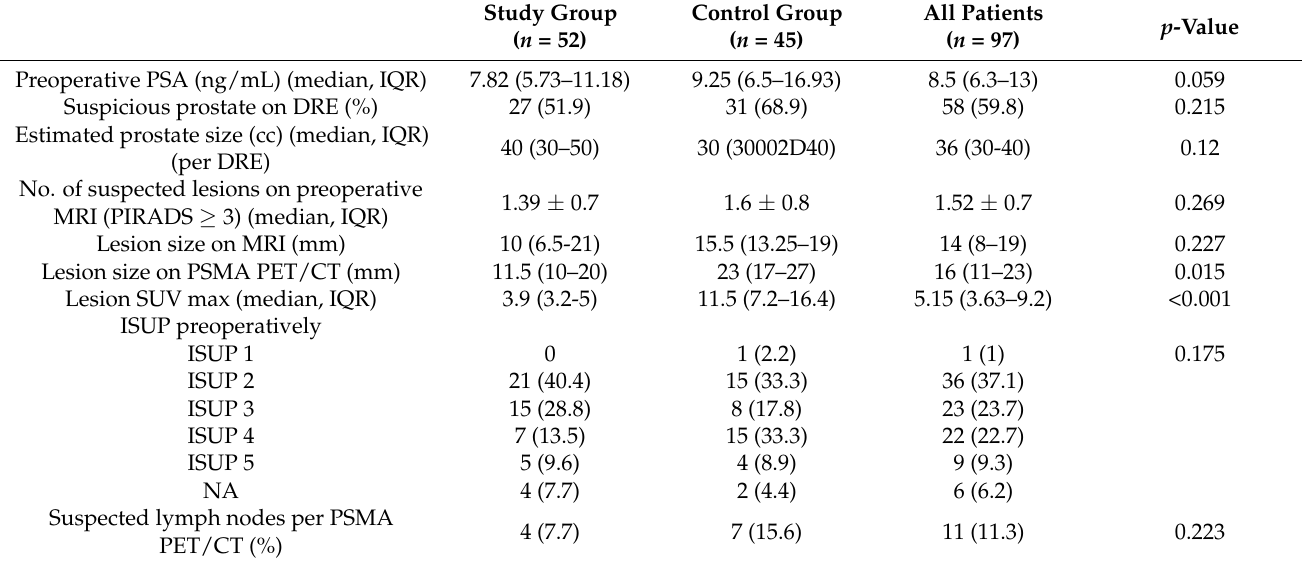
Table 2. Preoperative patient